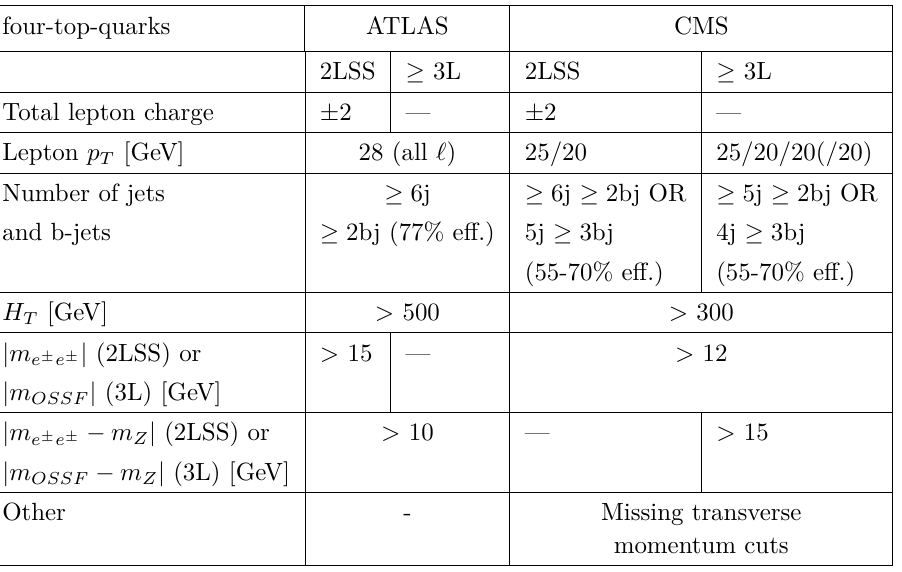
Table 3 . Comparison of event selections between the ATLAS [5] and CMS [6] four-top-quarks analyses. H is the scalar p sum of jets, leptons and T T